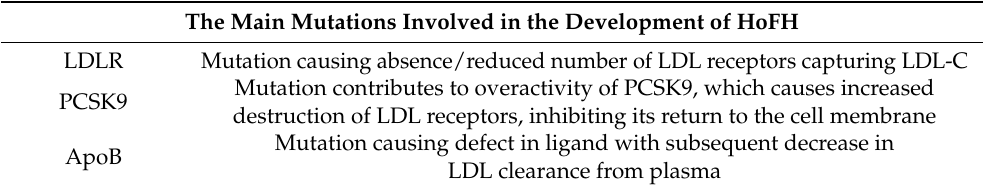
Table 1. A Brief Description of the Major Mutations Involved in the Development of HoFH [12,23]. The Main Mutations Involved in the Development of HoFH LDLR Mutation causing absence/reduced number of LDL receptors capturing LDL-C Mutation contributes to overactivity of PCSK9, which causes increased PCSK9 destruction of LDL receptors, inhibiting its return to the cell membrane Mutation causing defect in ligand with subsequent decrease in ApoB LDL clearance from plasma HoFH, Homozygous Familial Hypercholesterolemia; LDLR, Low Density Lipoprotein Receptor; LDL-C, Low- Density Lipoprotein Cholesterol; PCSK9, Proprotein Convertase Subtilisin Kexin Type 9; LDL,